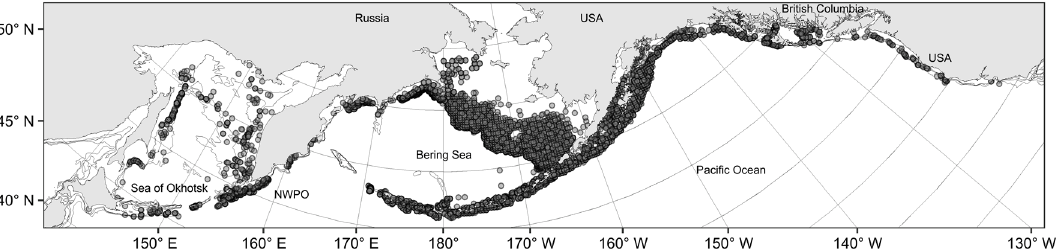
Figure 2. Sites of Aleutian skate Bathyraja aleutica captures ( ● ) in the North Pacific Ocean. According to the USA commercial fishing observer catch data from 1995 to 2021 (Figure 3), the Aleutian skate was the most numerous along the eastern Bering Sea slope, the Aleutian Islands, and the western part of the Gulf of Alaska, where its by-catch exceeded 0.6% of the total catch weight. From other areas in Alaskan waters, the by-catch of the Aleutian skate was considerably lower.